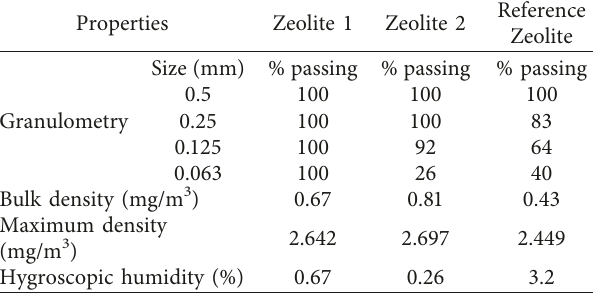
Table 1: Main physical properties of zeolites.